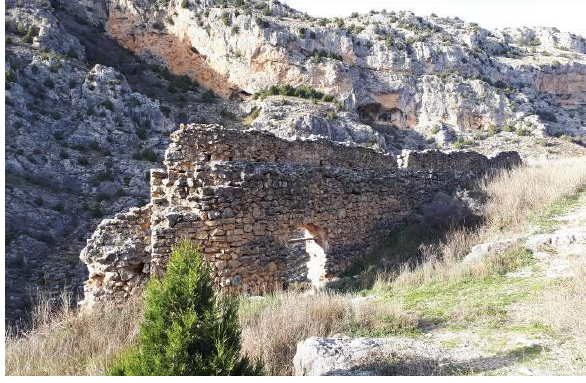
Figure 4. View of the wicket gate from the interior of the fortified precinct (J. Díaz).